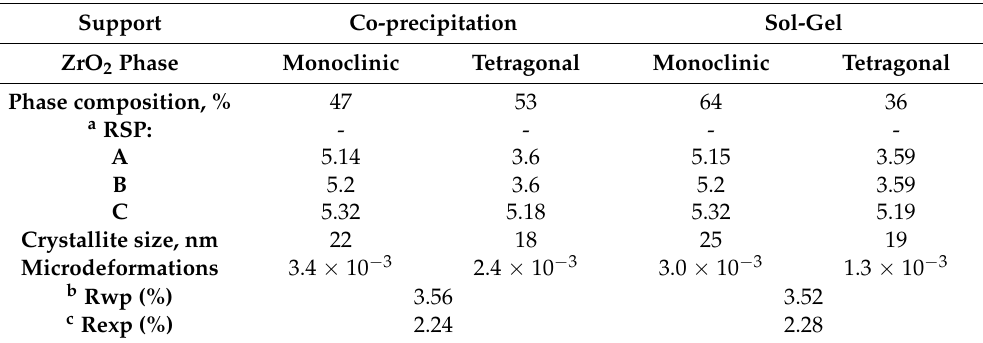
Table 2. Nitrogen physisorption analysis. Specific surface area and average pore diameter.